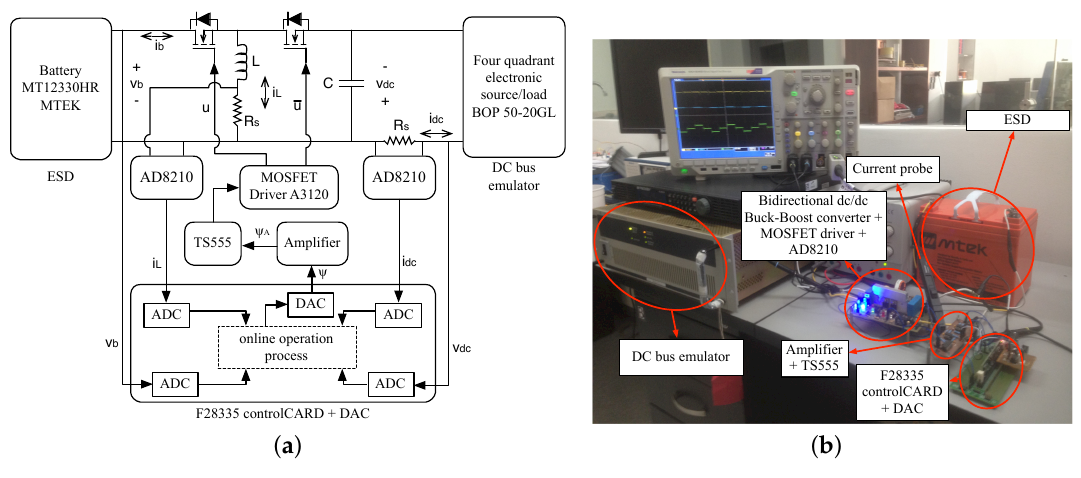
Figure 12. Experimental platform. ( a ) electrical scheme; ( b ) physical